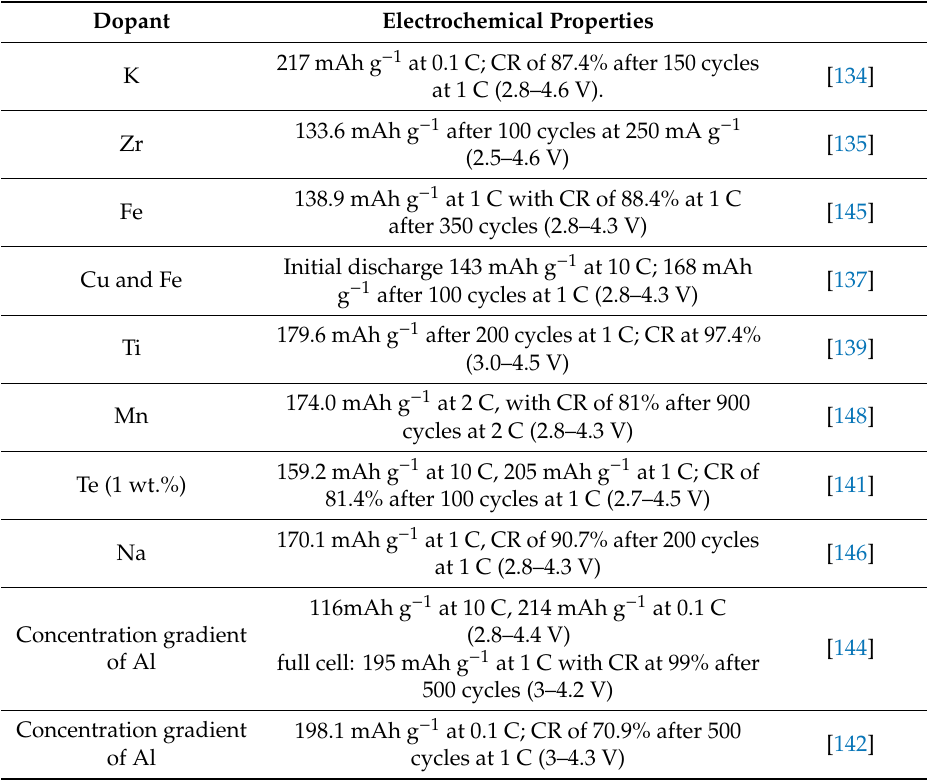
Table 2. Electrochemical properties of selected doped LiNi 0.80 Co 0.15 Al 0.05 O 2 cathode materials (CR = capacity